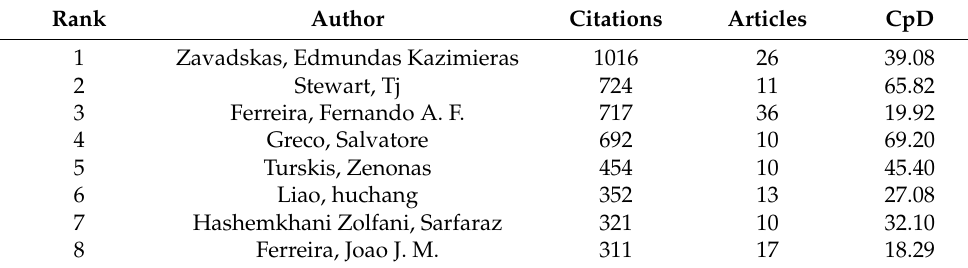
Table 2. Academic production of authors with more than 10 articles.